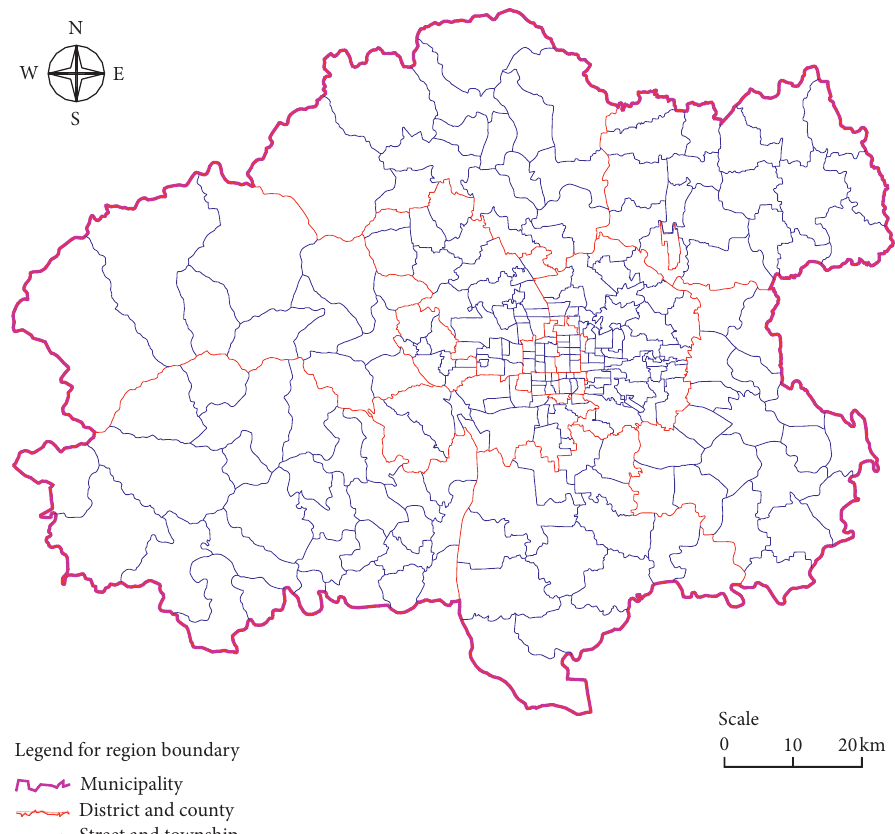
Figure 1: A zonal system of Beijing city with two levels: districts and residential area (2010). Note: Beijing municipality is divided into 18 districts and counties (thick red lines indicate boundaries). A district contains several streets, and a county contains several townships and towns (thin blue lines represent boundaries). There are 331 streets, towns, and townships in Beijing region. Thus, the zonal system of districts and counties includes 18 units, and the zonal system of residential areas includes 331 units.